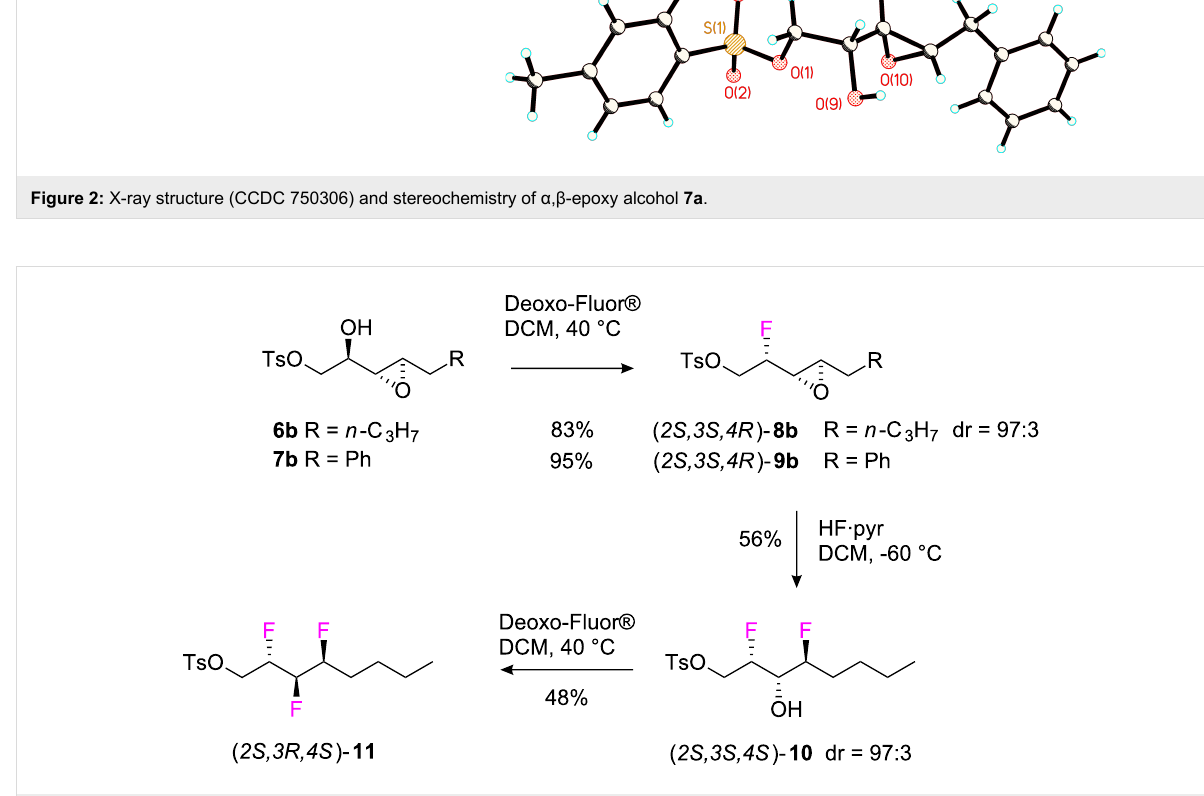
Scheme 4: Three step sequential fluorination from α,β-epoxy alcohols to eg. the vicinyltrifluoro tosylate 11